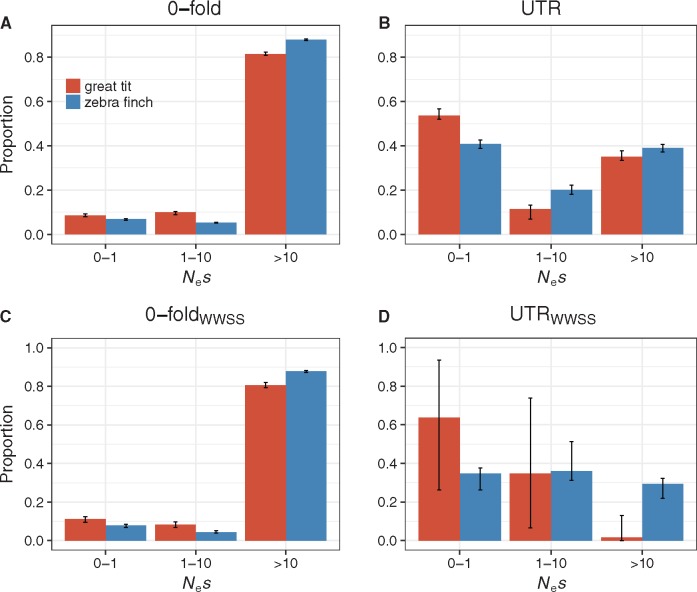
—Proportions of the DFE falling into different Nes ranges in the two species. Panels (A) and (B) were based on applying DFE-α to all changes, and panels (C) and (D) were based on WWSS changes.